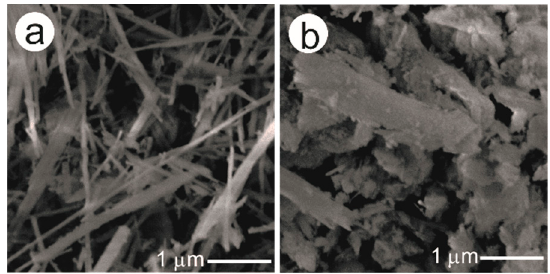
Figure 1. SEM images of the clay minerals after treatment with HCl(aq): ( a ) Palygorskite and ( b ) sepiolite.